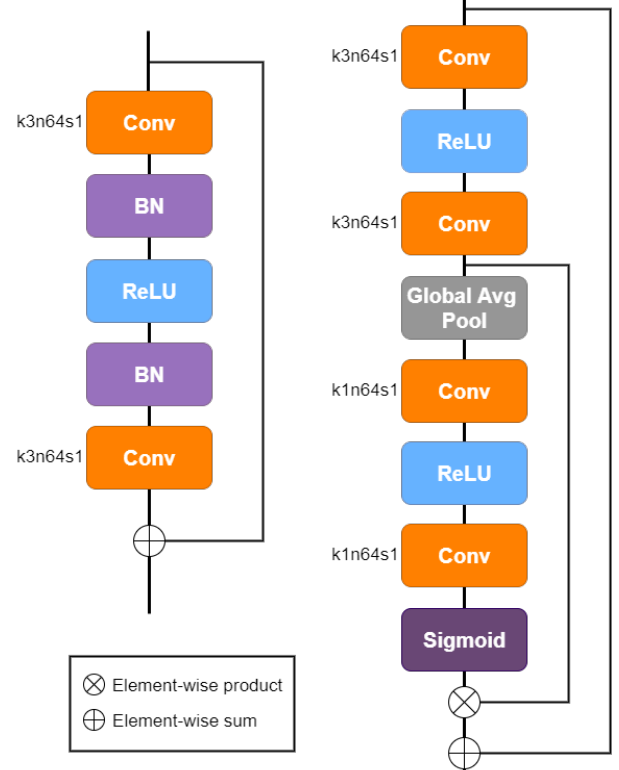
Figure 3. Comparison between the residual blocks in SRResNet ( left ) and RCAB in our model ( right ). As can be seen, the Batch Normalization layers have been removed. A channel attention block formed by a Global Average Pooling, convolution layers, a ReLU layer and a sigmoid activation function are also added.